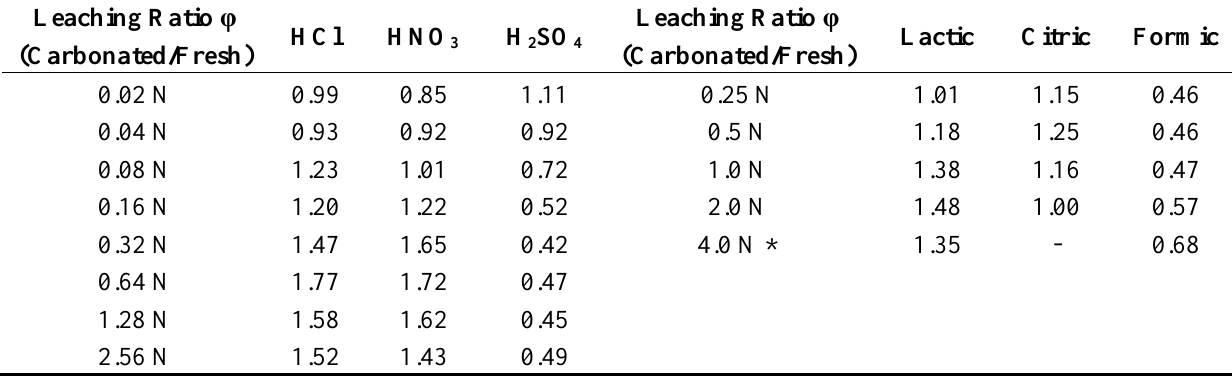
Table 4. Nickel leaching enhancement ratios of carbonated olivine over fresh olivine for inorganic and organic